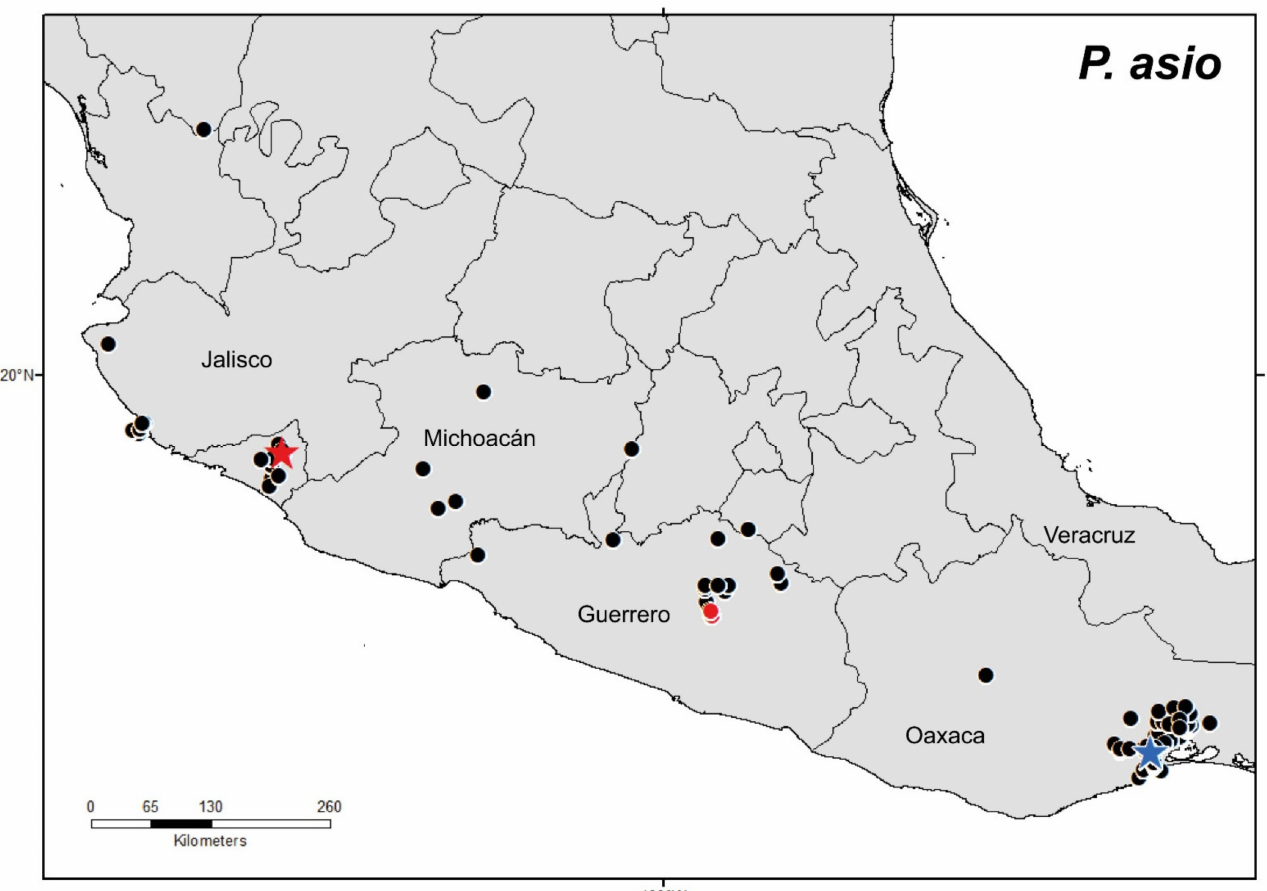
Figure 6. Map showing distributional records of Phrynosoma asio . Red circles = genetically confirmed records; black circles = records that have not been genetically confirmed; red star = type locality of P. asio ; blue star = type locality of P. spinimentum